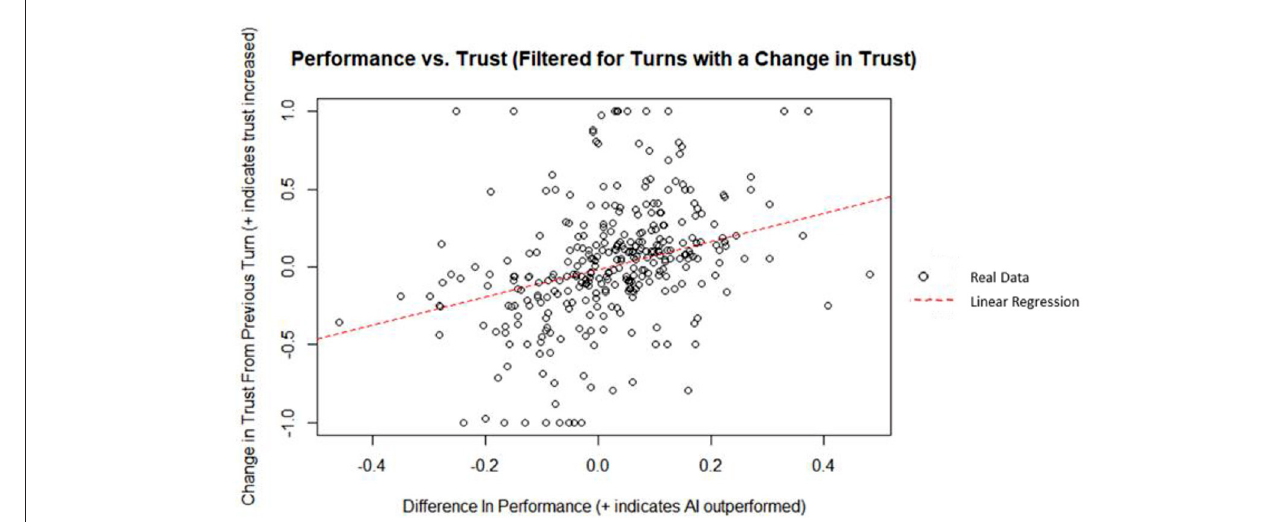
FIGURE 12 | Performance vs. trust (filtered for turns with a change in trust).